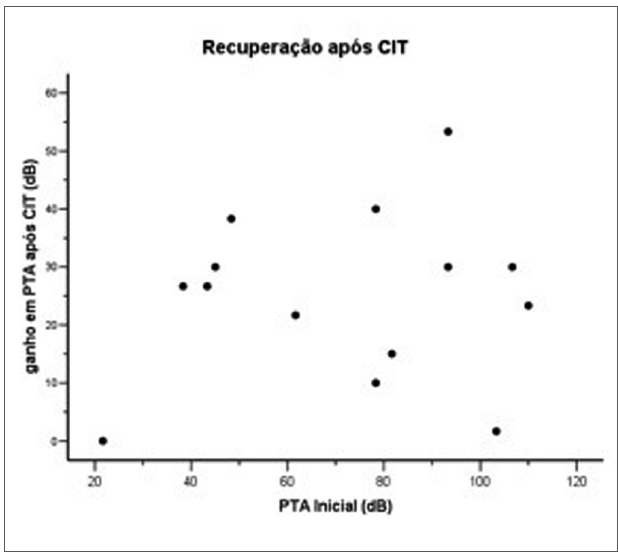
Figura 2. Relação da Recuperação após Corticoterapia Intratimpânica e Média Tritonal